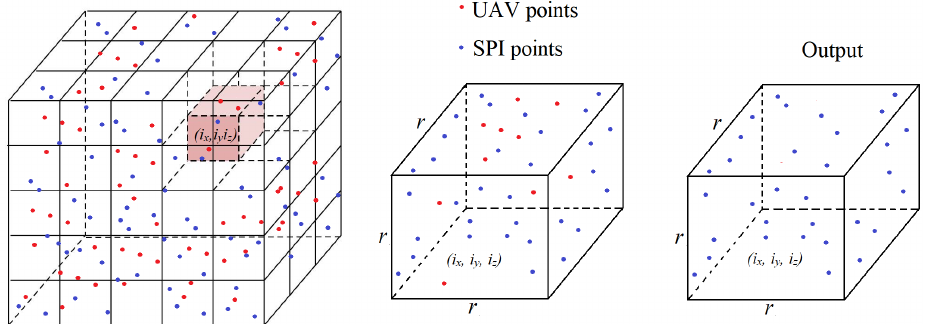
Figure 6. Octree structure proposed for selecting the source of points (UAV or SPI) to compose the final cloud. Each small cube (voxel) of side r is evaluated to define remaining and excluded points based on majority voting (output). In the presented example, SPI points were